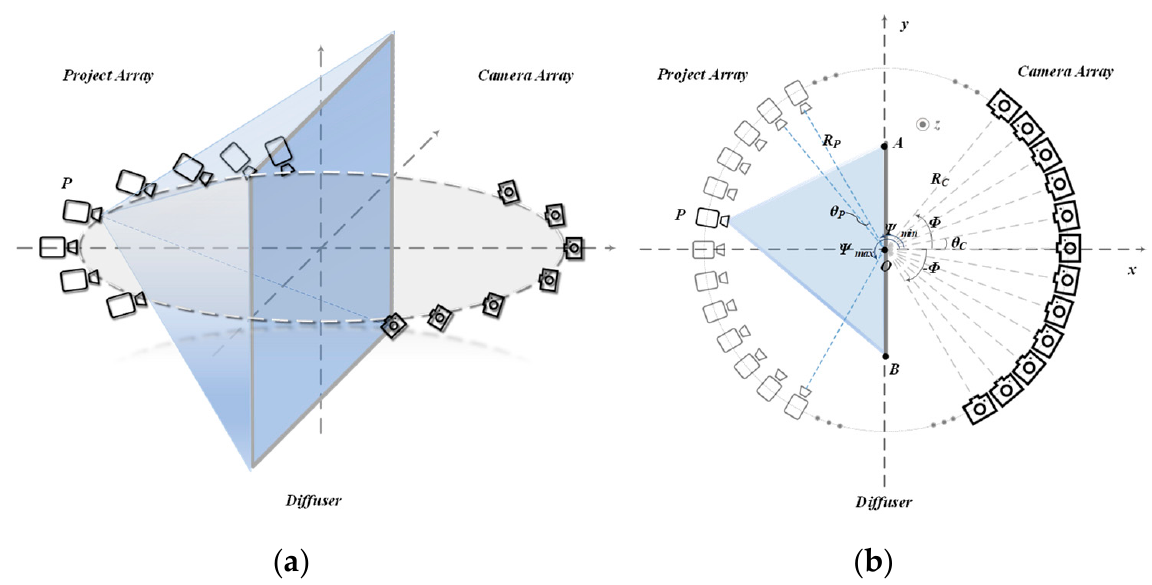
Figure 1. Stereogram ( a ) and top view ( b ) of the capture and display ends.